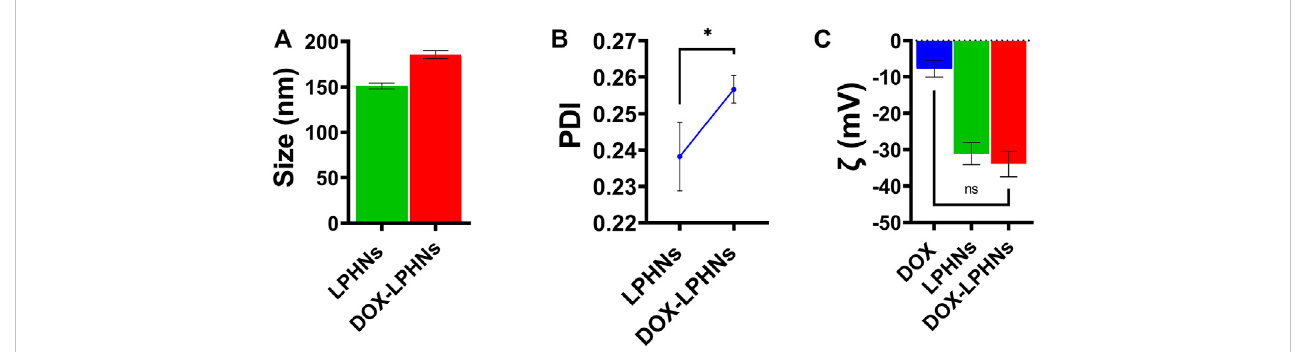
FIGURE 2 Surface characterization of LPHNs and DOX-LPHNs. (A) Average particle size of LPHNs and DOX-LPHNs (B) Polydispersity Index of LPHNs and DOX- LPHNs (C) Zeta potential ( ζ ) of LPHNs and DOX-LPHNs. One sample t -test (two tailed), p value = 0.0999.